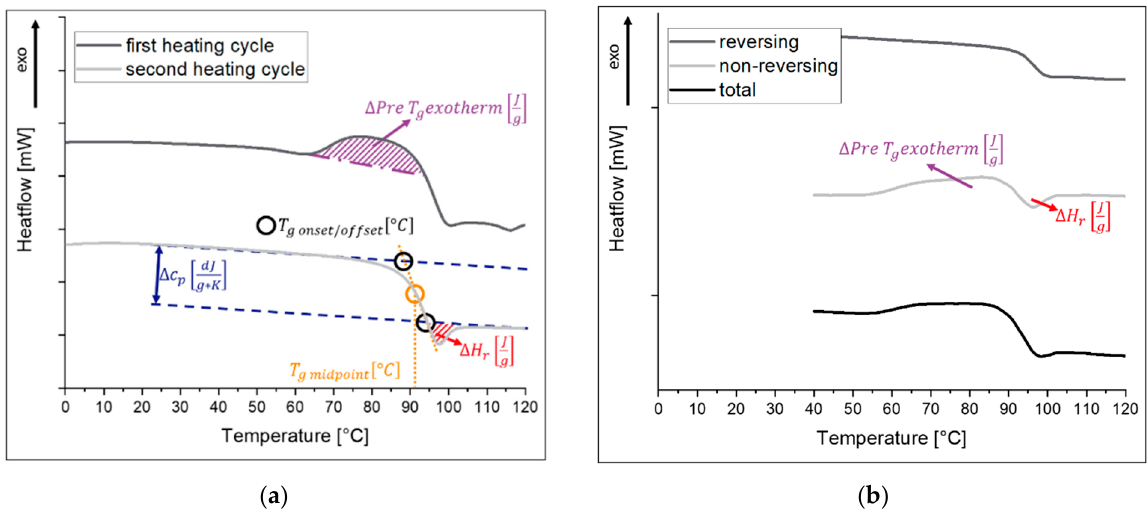
Figure 2. DSC thermograms of a freeze-dried trehalose-based pharmaceutical placebo formulation. The curves are displayed with offset for a better graphical presentation: ( a ) measured with a linear temperature program with two heating cycles; ( b ) measured in modulated mode (mDSC).